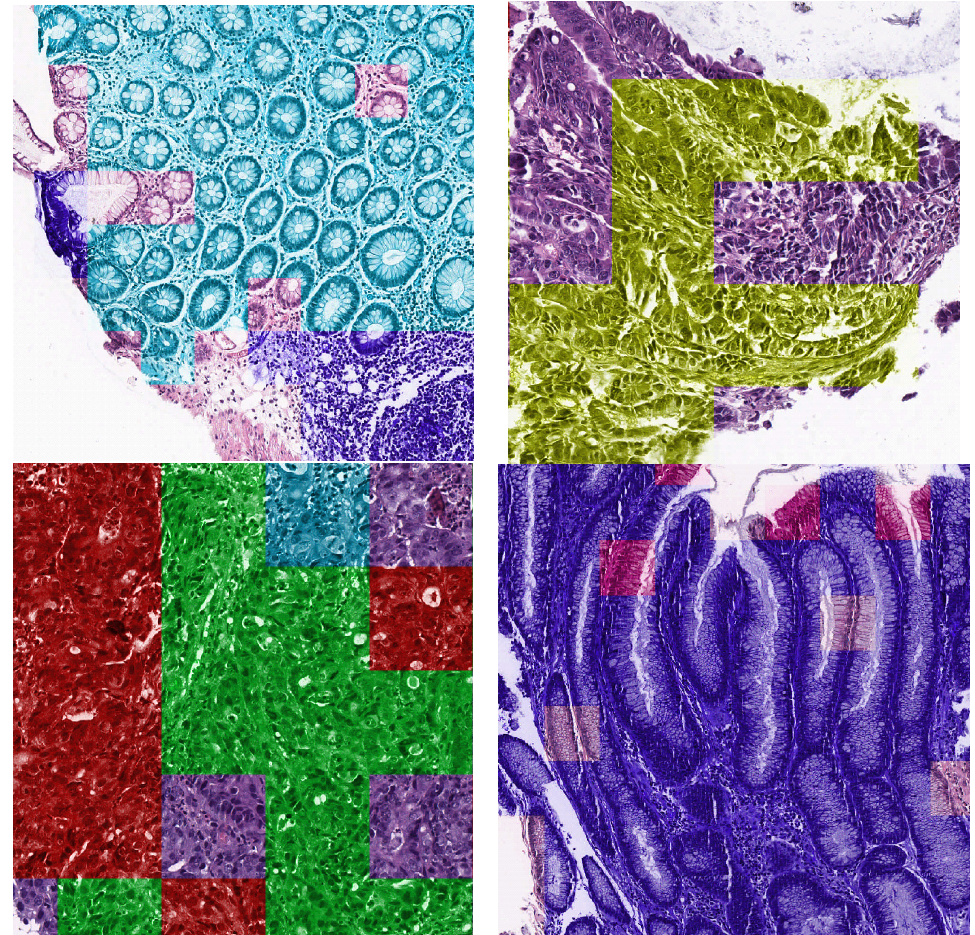
Figure 8. Examples of CNN predictions. The patches were painted when the predicted class probability was greater than